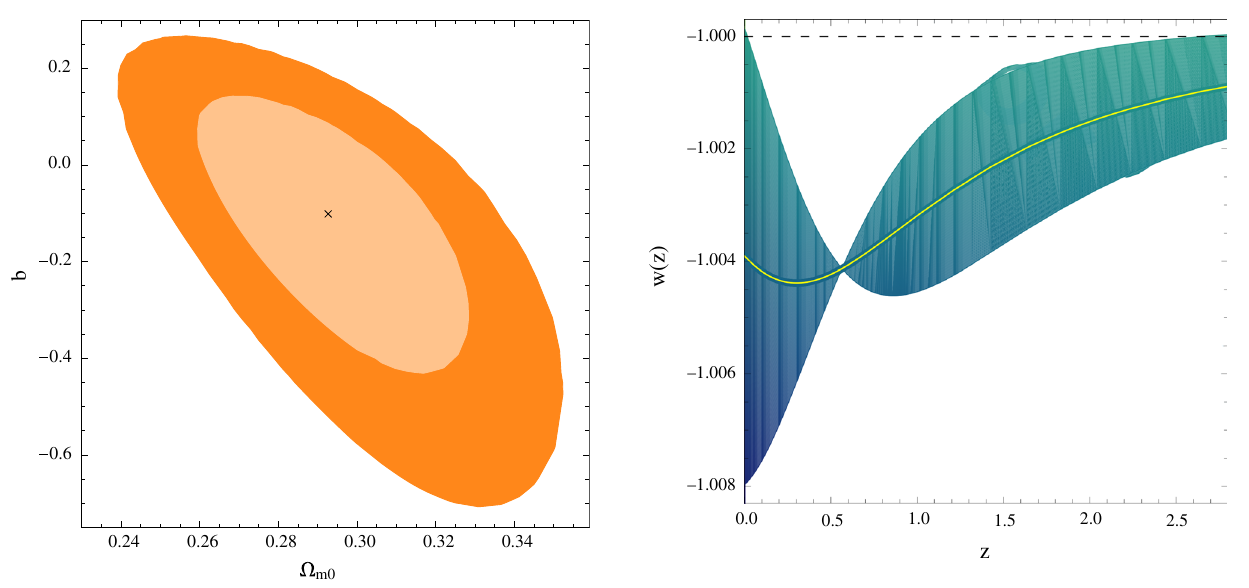
Fig. 2 The evolution of the equation-of-state parameter given in (11), Fig. 1 1 σ and2 σ confidenceregionsforthe f 1 CDMpower-lawmodel for the f 1 CDM power-law model of (12), applying a reconstruction at of (12), obtained from the joint analysis (cid:18)α/α + SNIa + BAO. The 1 σ confidence level via error propagation using the joint analysis (cid:18)α/α cross marks the best-fit value + SNIa + Table 2 Summary of the best-fit values of the parameter b of the f 1 CDM power-law model of (12), for three different observational data / d . o . f . (d.o.f. stands for the “degrees of free- sets with reduced χ 2 : χ 2 min